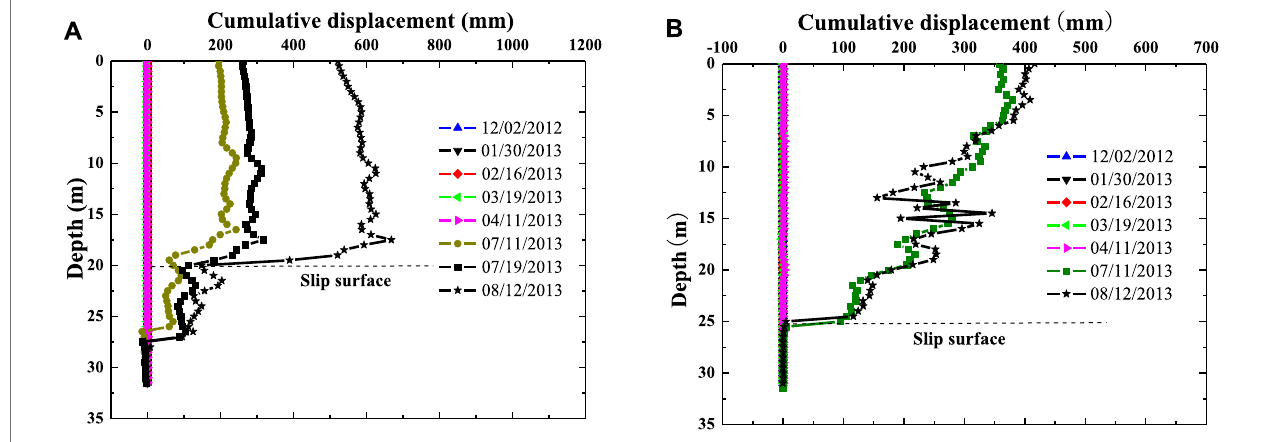
FIGURE 9 | Relationships between cumulative displacement and depth at different times. measured by (A) 1# SAA and (B) 2# SAA.